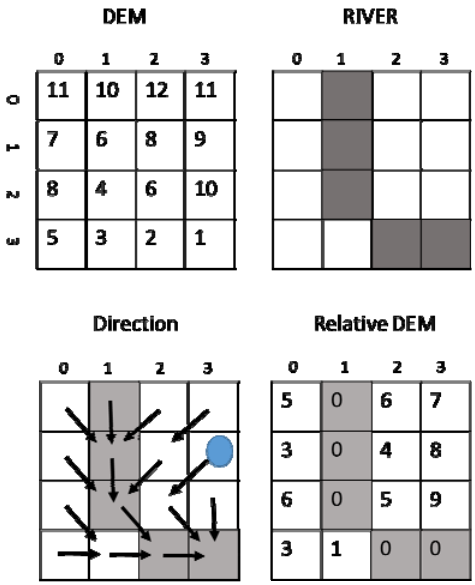
Figure 2. Calculation of relative